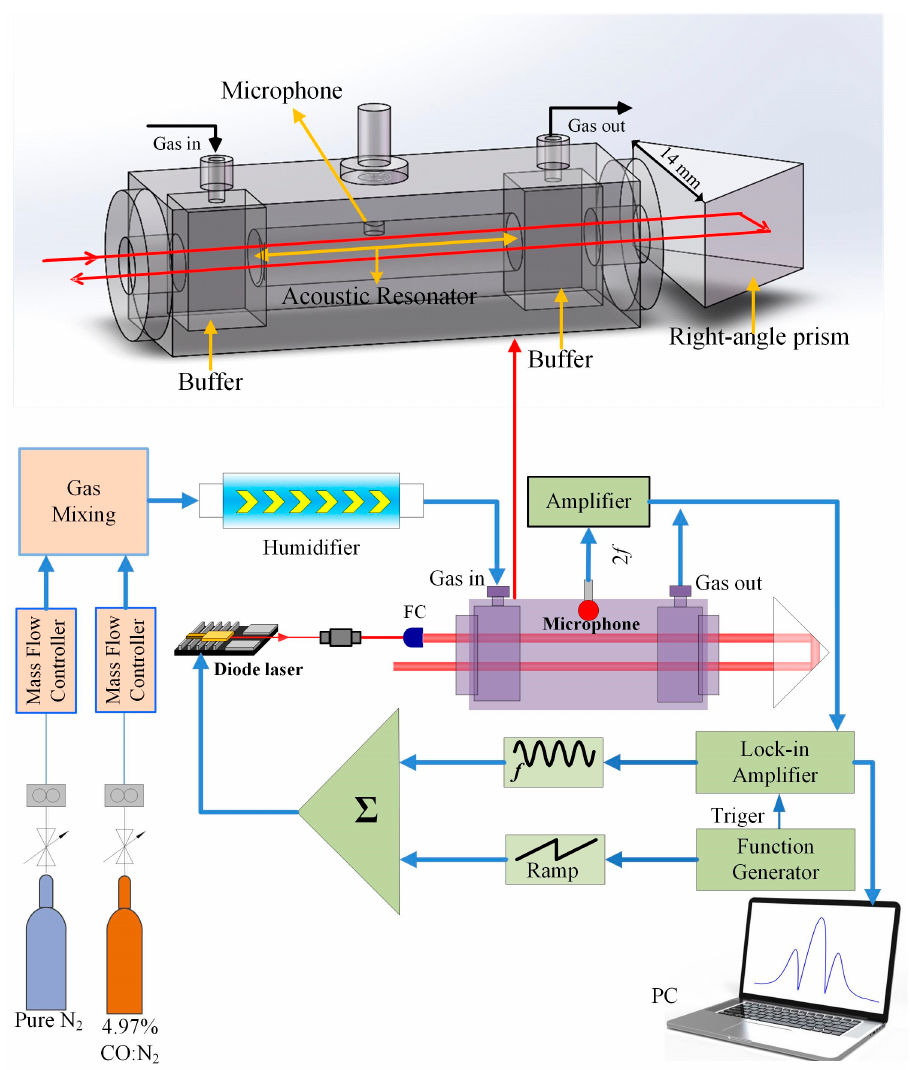
Figure 3. Schematic configuration of the photoacoustic spectroscopy (PAS)-based sensor system. FC: fiber collimator.